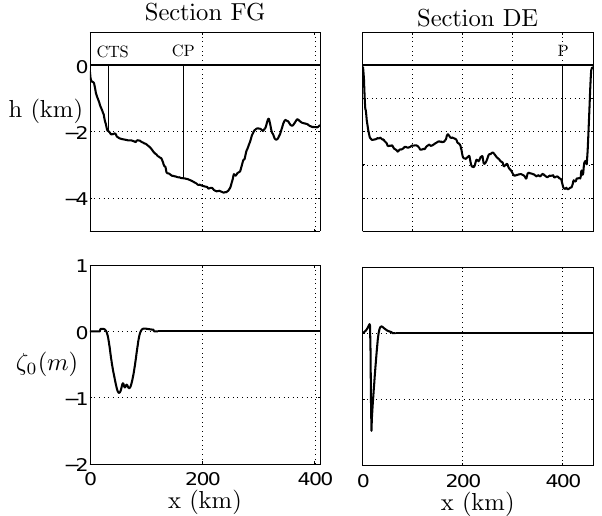
Figure 8. Upper panels: vertical sections FG and DE of Fig. 7. Lower panels: residual vertical seabed displacement ζ 0 relative to the above vertical